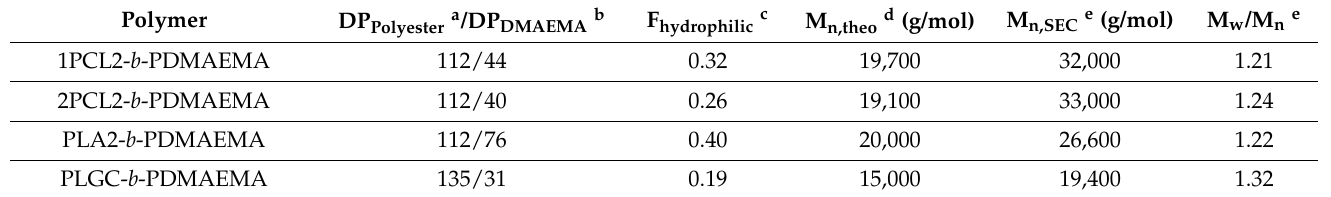
Table 2. Characterization of polyester- b -PDMAEMA linear block